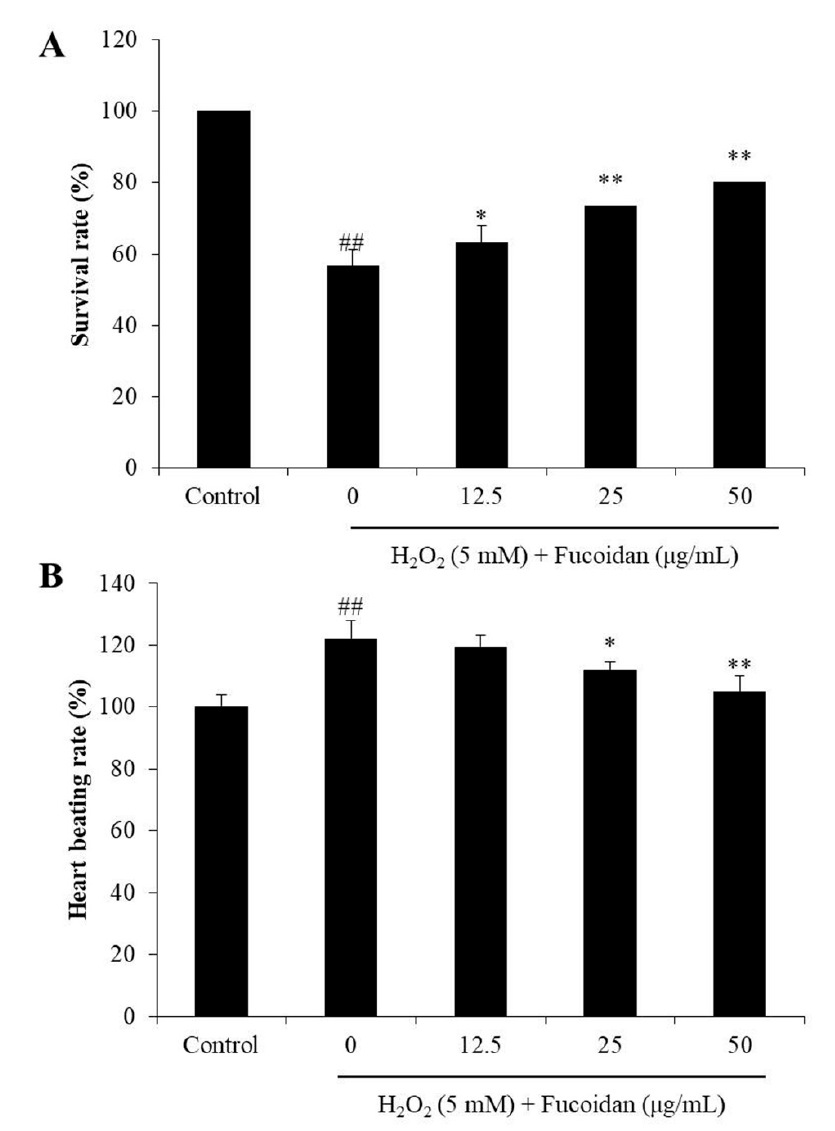
Figure 5. The effect of fucoidan on H 2 O 2 -induced alterations in survival rate and heart-beating rate of zebrafish. ( A ) The survival rate of zebrafish; ( B ) the heart-beating rate of zebrafish. The experiments were conducted in triplicate, and the data are expressed as the mean ± SE. * p < 0.05, ** p < 0.01 as compared to the H 2 O 2 -treated group and ## p < 0.01 as compared to the control